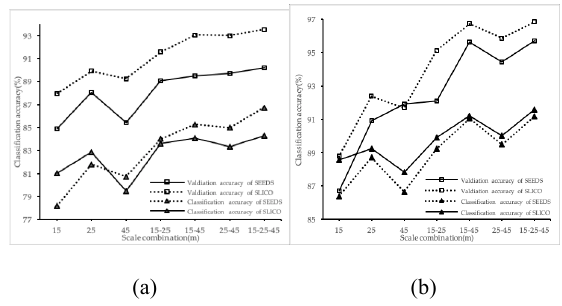
Figure 8. Validation accuracy and classification accuracy with different !